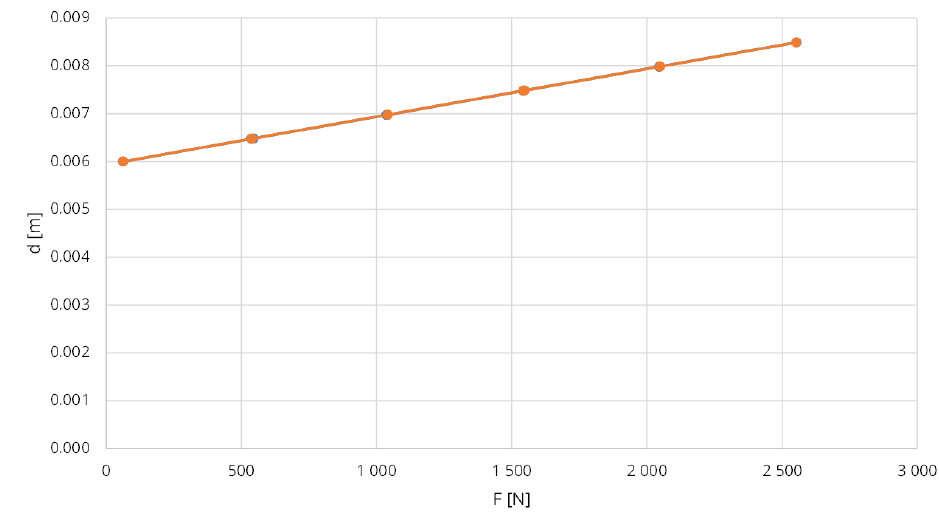
Figure 11. Measurement of the compaction path by the servo-hydraulic testing machine.